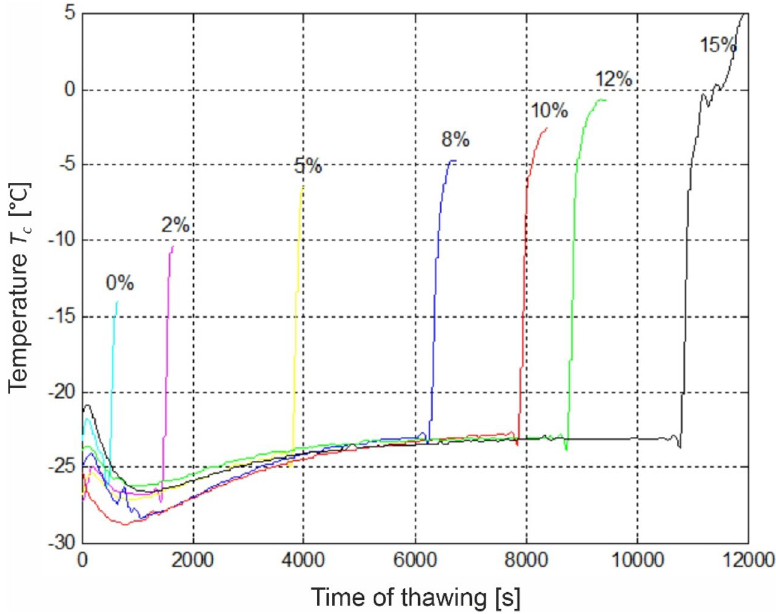
Figure 3. The temperature T c changes in the centre of sample during thawing SRVST method for different degrees of sublimation dehydration S s